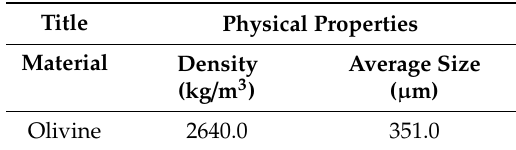
Table 1. Characterizationof the olivine sand.